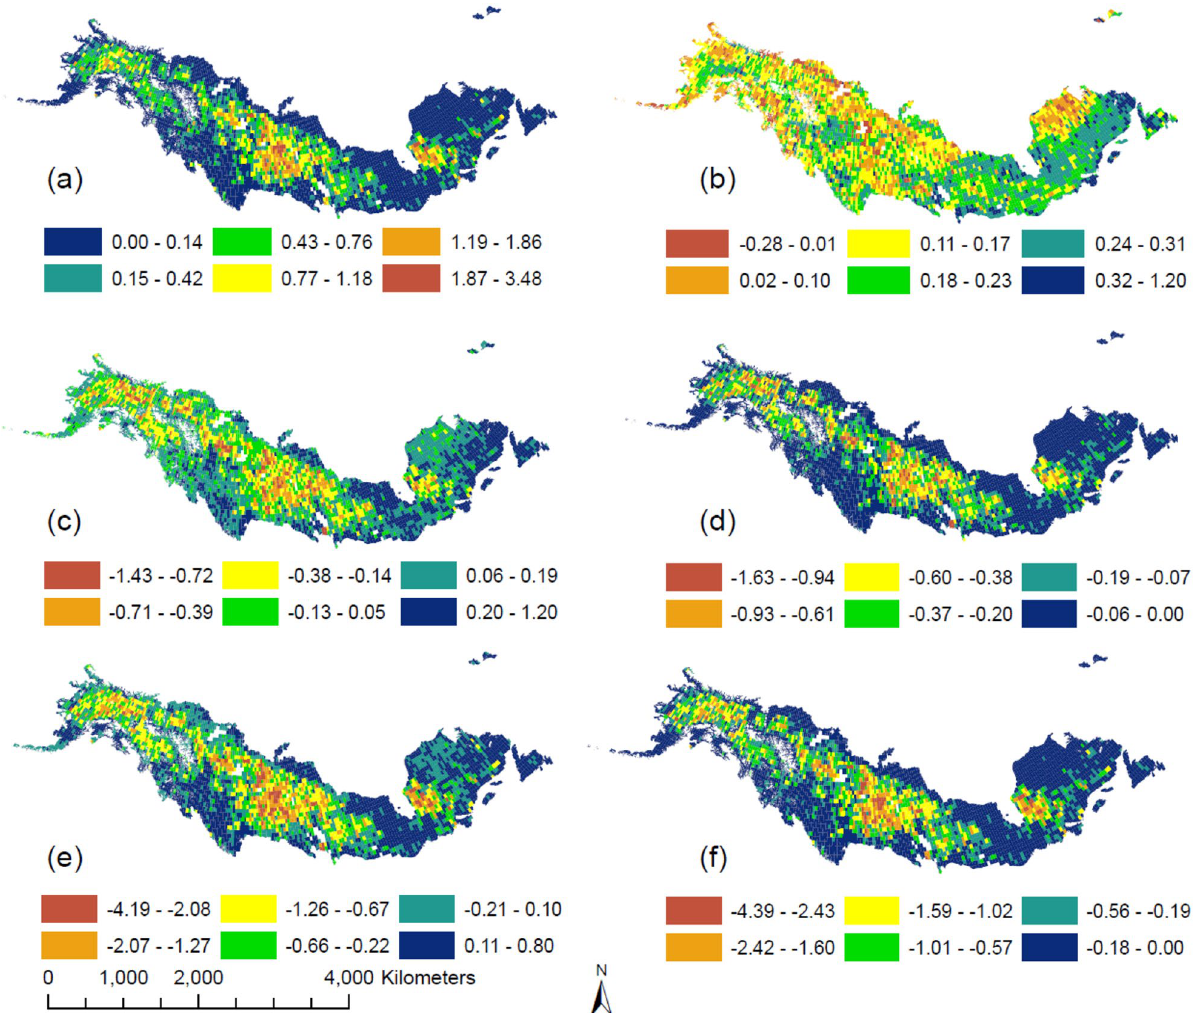
Figure 3. Spatial pattern of C sequestration and emission, accumulated for 1986–2016 (Gg km −2 ): ( a ) total emissions from direct combustion (both vegetation and soil); ( b ) cumulative NEP without considering fires, i.e., the distribution of ecosystem C storage when there is no fire; ( c ) cumulative NEP considering fires; ( d ) difference of cumulative NEP with and without considering fires (c minus b); ( e ) changes in ecosystem C storage considering fires; ( f ) difference of ecosystem C storage between simulations with and without fires (the former minus the latter). This figure was created by ArcMAP 10.7.1, (https:// www. esri. com/ en- us/ arcgis/ produ cts/ arcgis- maps- for- office/ downl